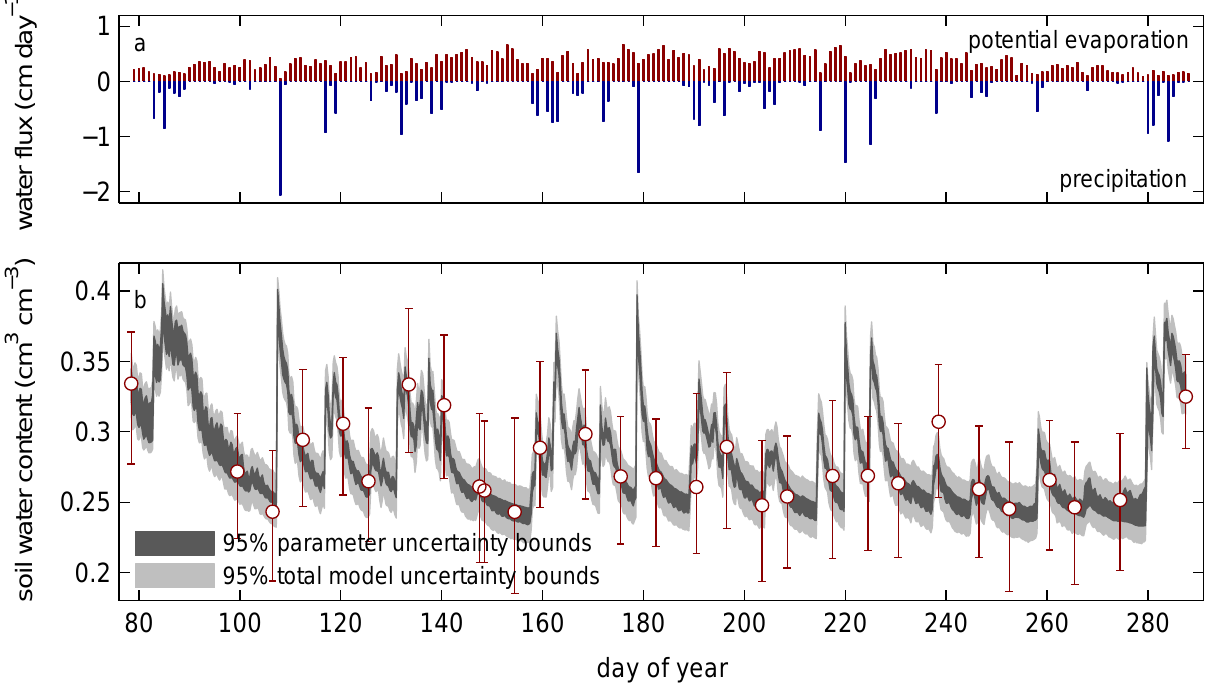
Fig. 8. 95% predictive uncertainty bounds using real soil water content data: (a) meteorological forcing and (b) observed and predicted soil water content. The dark grey region represents the predictive uncertainty due to uncertainty in the estimated parameters. The light grey region denotes the predictive uncertainty due to the combined effects of parameter, model, boundary condition and calibration data uncertainty. The red circles mark the mean values of the spatially distributed soil water content observations, while the red bars span the 2.5% and 97.5% quantiles of these observations. Note that we depict daily values of potential evaporation and precipitation, but the HYDRUS-1D model was actually run with hourly values of these forcing